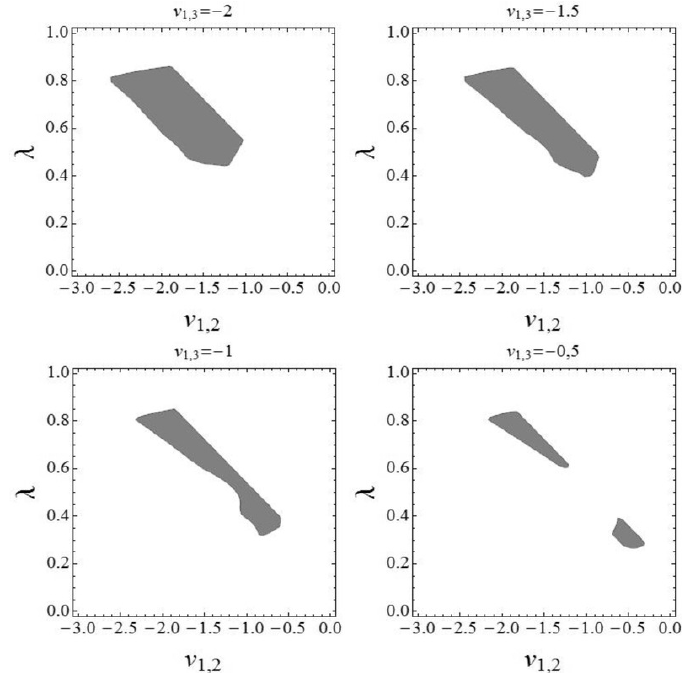
Figure 2. A - and L -stable methods of stage order q = 5 and order p = 6